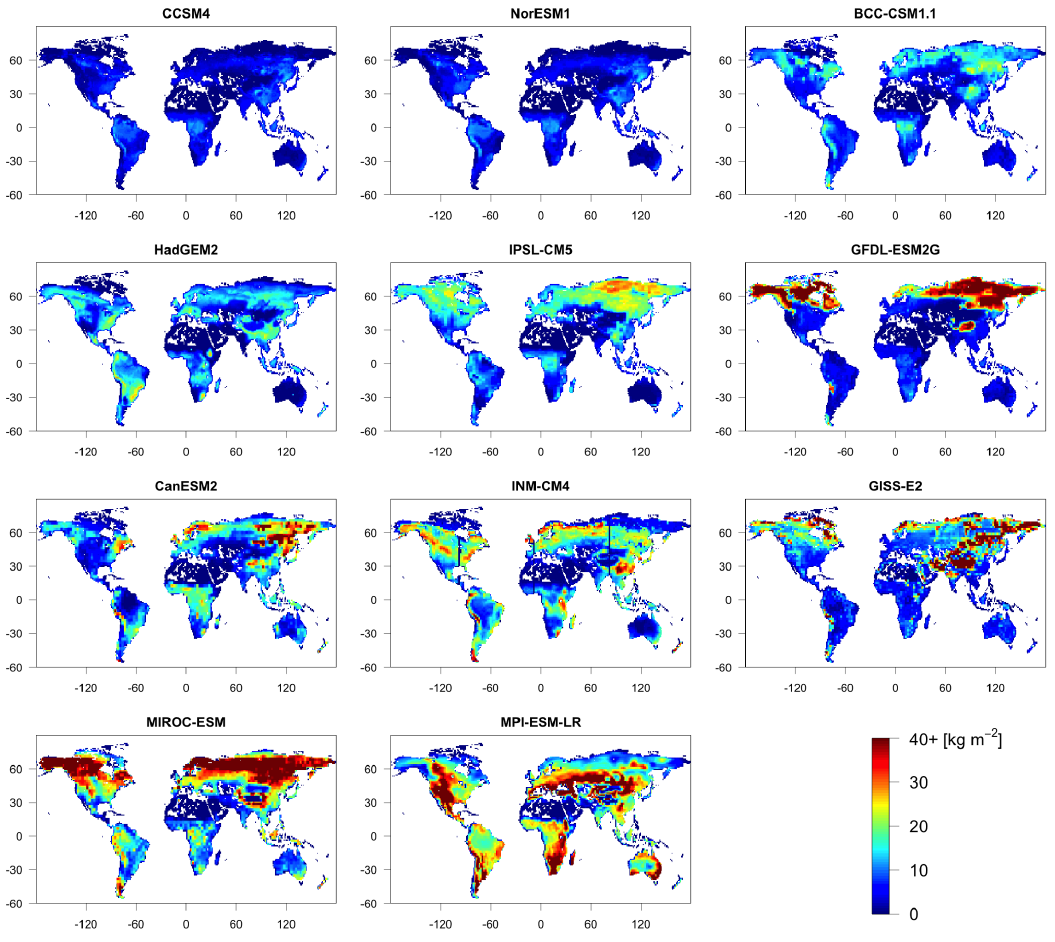
Fig. 3. Soil carbon densities [kgm − 2 ] from Earth system models. These soil carbon densities represent 1995–2005 means from the historical simulations of the Climate Model Intercomparison Project